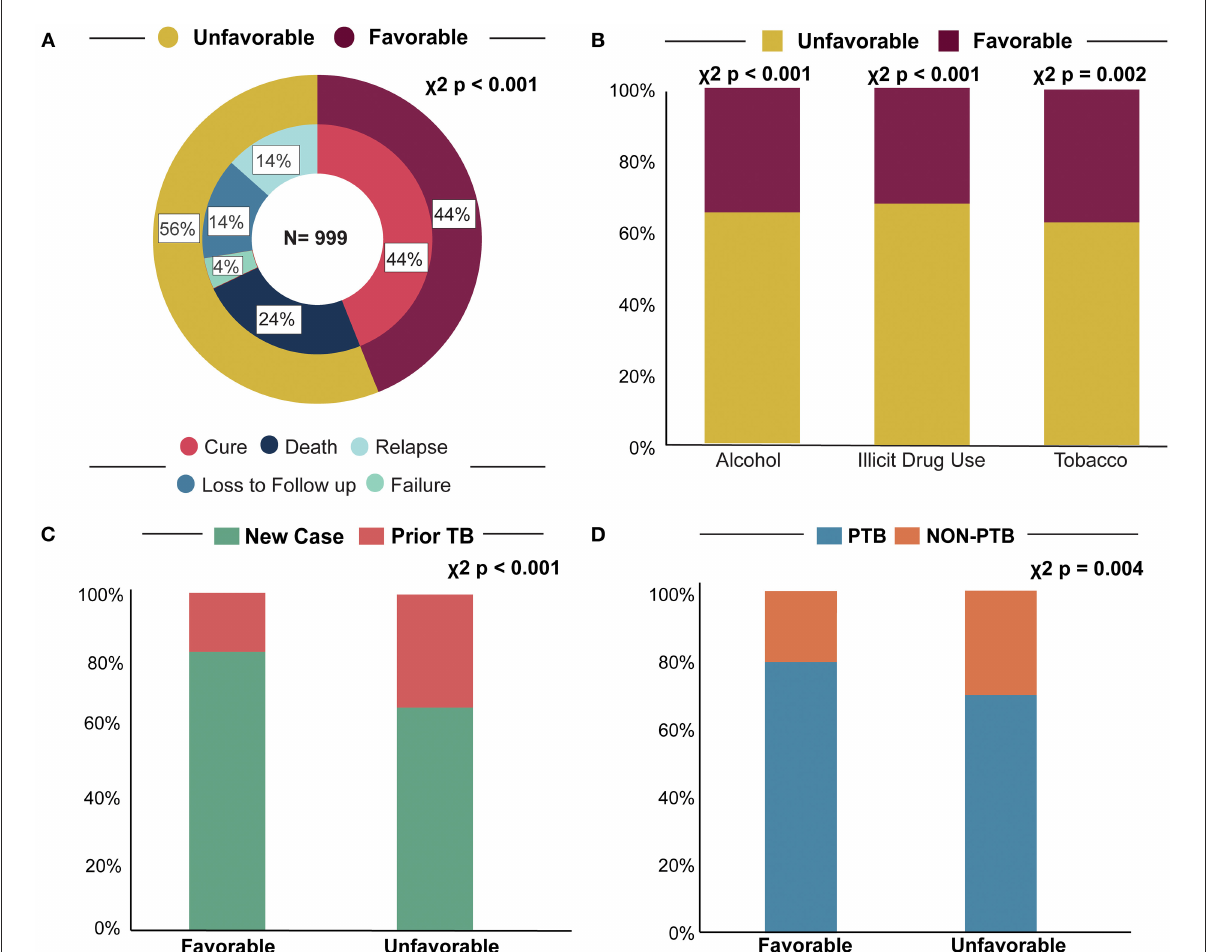
FIGURE1 Determinant factors for treatment outcome. (A) Treatment outcome, most TB-HIV-DM patients had an unfavorable treatment outcome (B) . Consumption habits, we demonstrated that alcohol consumption, illicit drug, and tobacco usage all had higher rates of negative outcome. (C) TB status, we found that being a new case of TB had a protective factor against unfavorable outcomes in patients with TB-HIV-DM. (D) TB type, we observed that patients with PTB obtained a higher percentage of favorable outcomes, while non-PTB cases had higher rates of negative outcome. TB, tuberculosis; PTB, pulmonary tuberculosis; Non-PTB, extrapulmonary and disseminated tuberculosis.